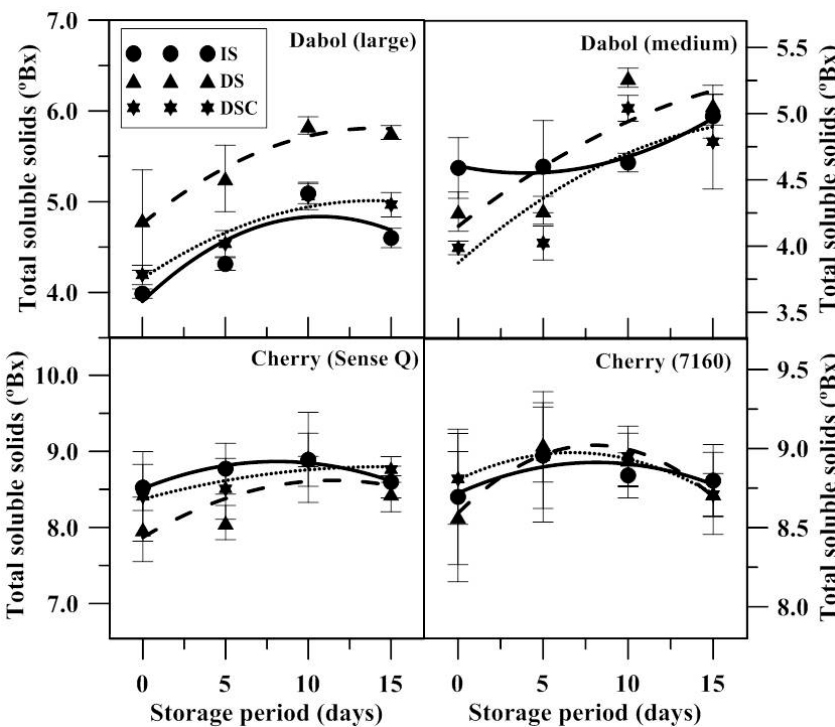
Figure 4. Changes in total soluble solid (TSS) content of four tomato cultivars over 15 days of storage under IS (immediate storage), DS (storage delayed 24 h), and DSC (storage delayed 24 h under cover) postharvest treatments.